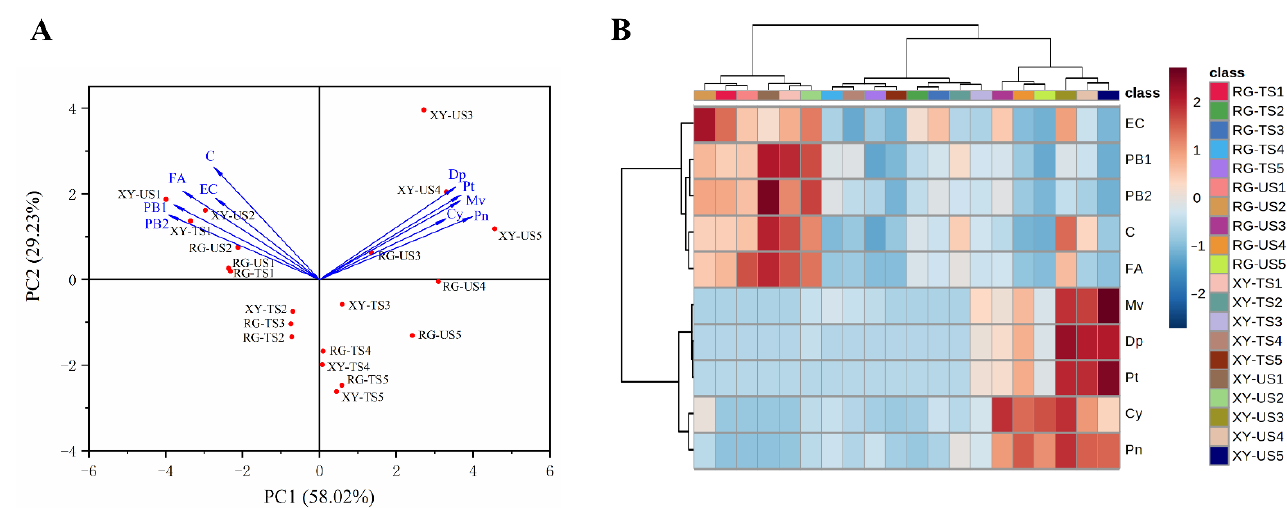
Figure 4. Principal component analysis ( A ) and cluster analysis ( B ) in grape berries during the five developmental stages in Urumqi and Turpan. RG − U, Urumqi ‘Red Globe’ grapes; RG − T, Turpan ‘Red Globe’ grapes; XY − U, Urumqi ‘Xin Yin’ grapes; XY − T, Turpan ‘Xin Yu’ grapes. RG − US1, RG − US2, RG − US3, RG − US4, RG − US5, XY − US1, XY − US2, XY − US3, XY − US4, RG − US5, RG − TS1, RG − TS2, RG − TS3, RG − TS4, RG − TS5, XY − TS1, XY − TS2, XY − TS3, XY − TS4, and RG − TS5 stand for